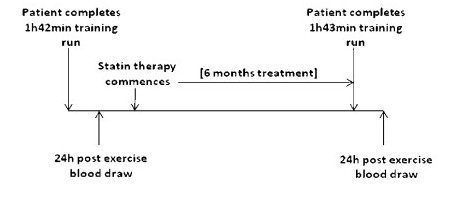
Case Study Design.